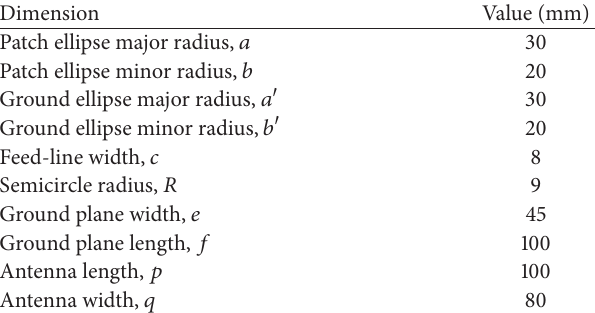
Figure 8: Simulated current distribution of the (a) antenna patch and (b) ground plane. Table 1: Design specification of the antenna. Dimension Value